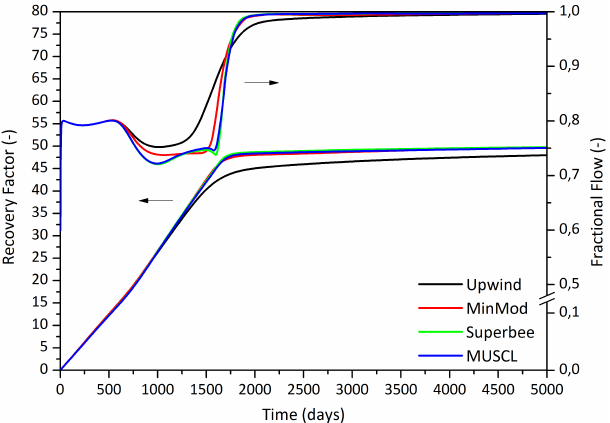
Figure 5. Oil recovery during a tertiary flooding with polymers, comparing the results from a first-order Upwind scheme [48] with the second-order TVD functions used in this paper (Adapted from Druetta